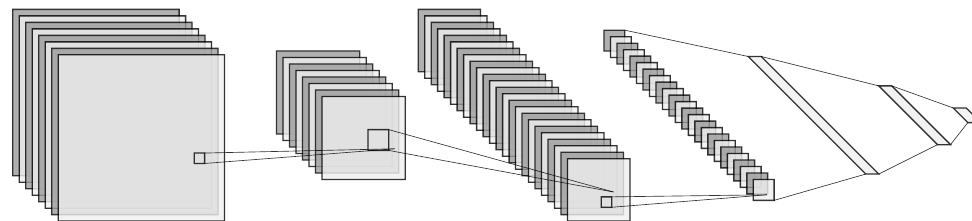
Figure 1. A high-level illustration of a deep learning (DL) object detection network architecture. Layered squares represent feature maps. The connection between stacked feature maps represents convolutional operations. Elongated rectangles to the right represent feature vectors. The connections between feature vectors represent fully connected operations. This figure is created using the tool from [10].